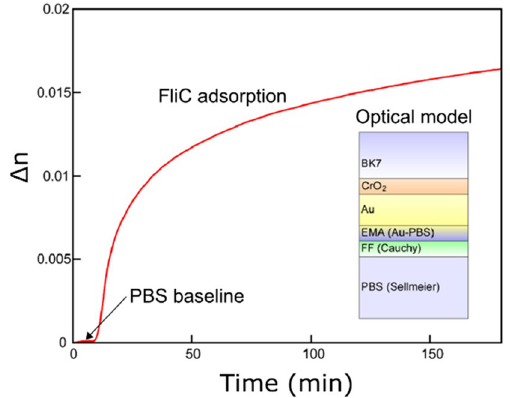
Figure 3. Change in the refractive index (Δn) near to the surface of a DSP-functionalized gold layer caused by the adsorption of flagellar filaments from their 0.5 mg/mL suspension. The kinetic curve was recorded by in situ spectroscopic ellipsometry. The inset shows the optical model used for data evaluation.